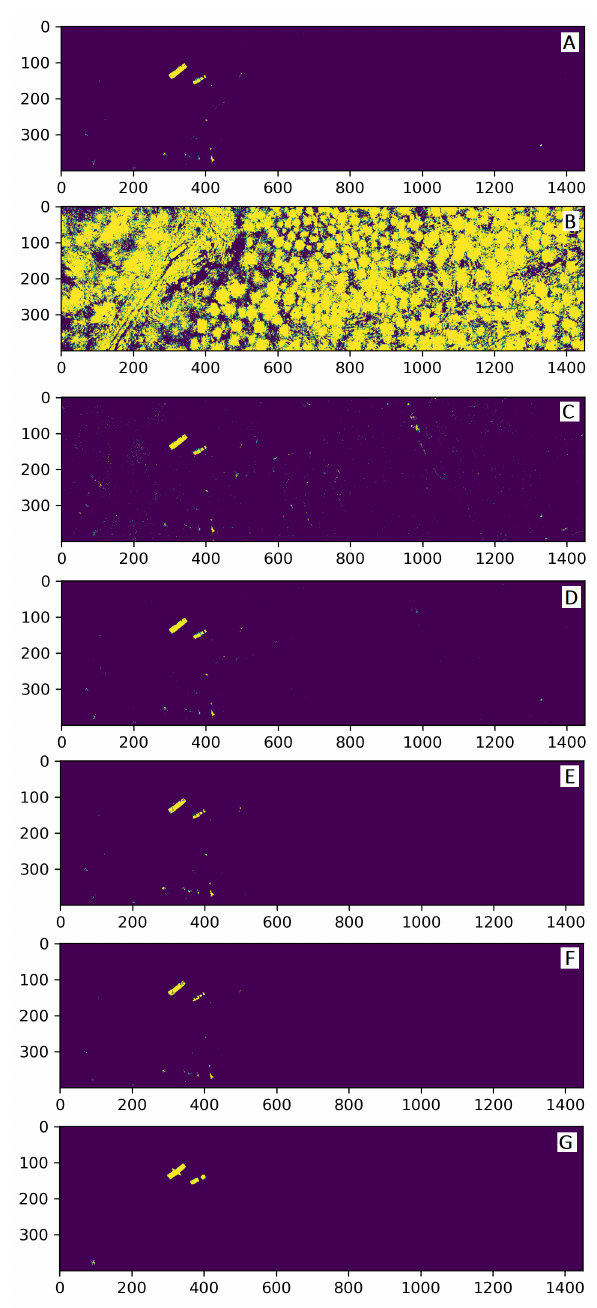
Figure 9: Comparison of the MLM (A-D) and the piecewise MLM (E-F) with the Ground truth (G) with the forest data. Thresholds and accuracy rates of the images are shown on Ta- ble 3.